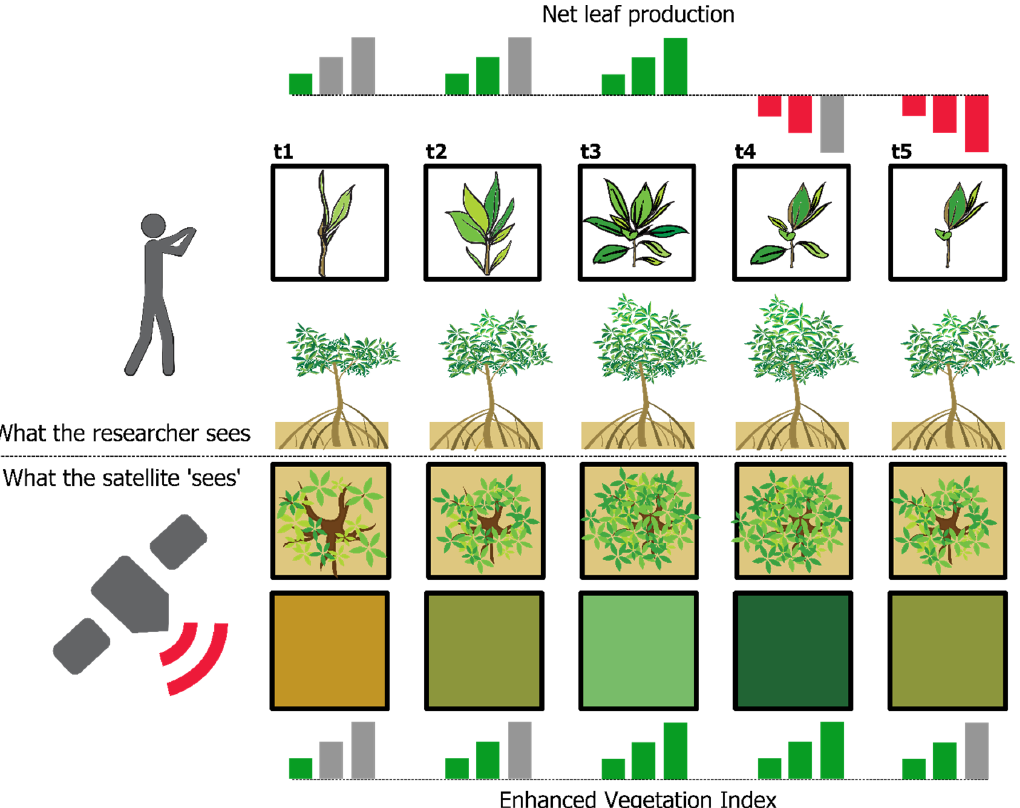
Figure 8. Time difference between peak leaf production and peak EVI during a given year for a Figure 8. Time di ff erence between peak leaf production and peak EVI during a given year for a simulated mangrove tree. simulated mangrove